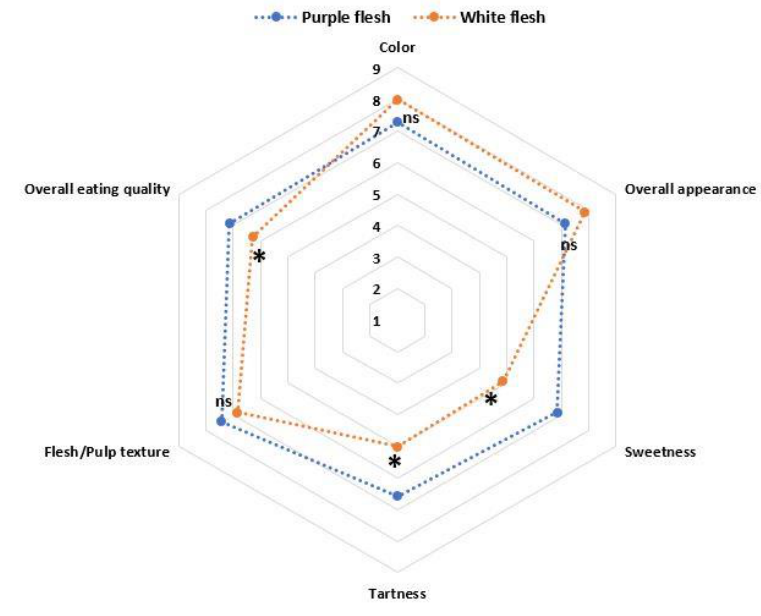
Figure 10. Sensory profiles (color, overall appearance, flavor, sweetness, tartness, flesh texture and overall eating quality) of two varieties of pitaya immediately after harvest. Sensory scores were expressed using a 9-point hedonic ratings where 1: extremely dislike, 5: neither like nor dislike, and 9: extremely like. The results shown are the means ± SD ( n = 20). Pair-wise statistical comparisons were calculated with a two-tailed Student’s t -test and asterisk indicates statistical significance ( p ≤ 0.05) while ns indicates a lack of significance.